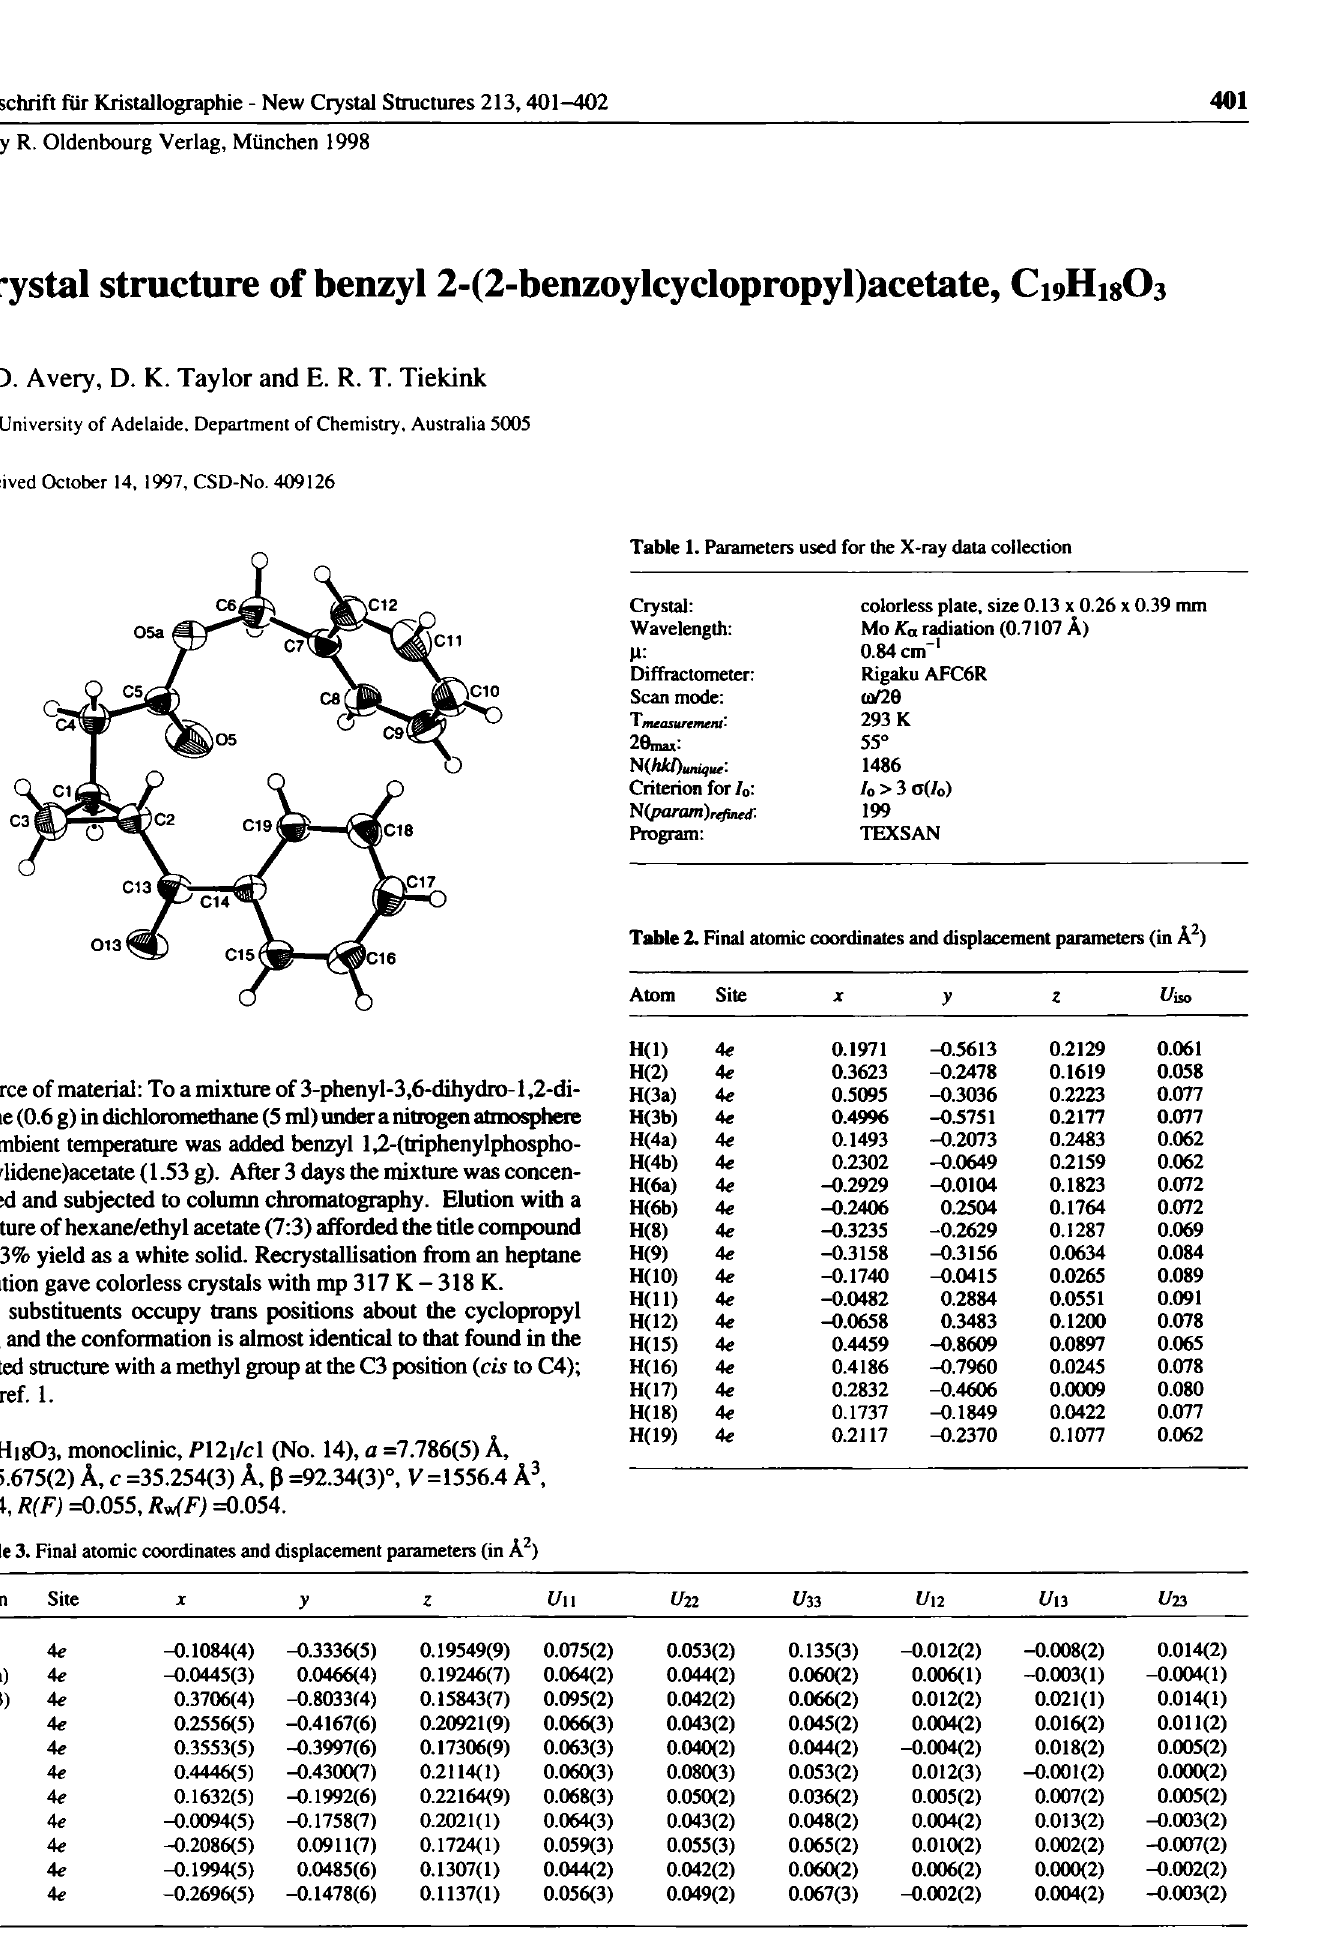
Table 3. Final atoniic coordinates and displacement parameters (in Â^)